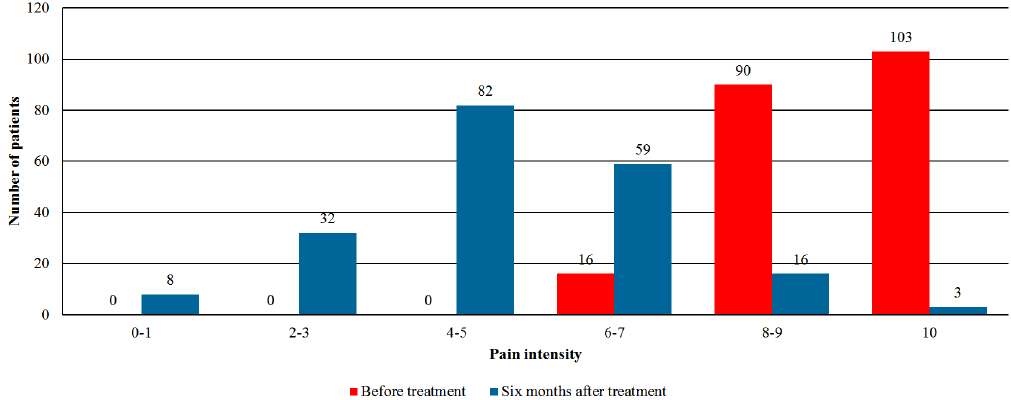
Figure 3. Assessment of the pain intensity on the 0–10 scale before and after six months of cannabis therapy ( p < 0.001).